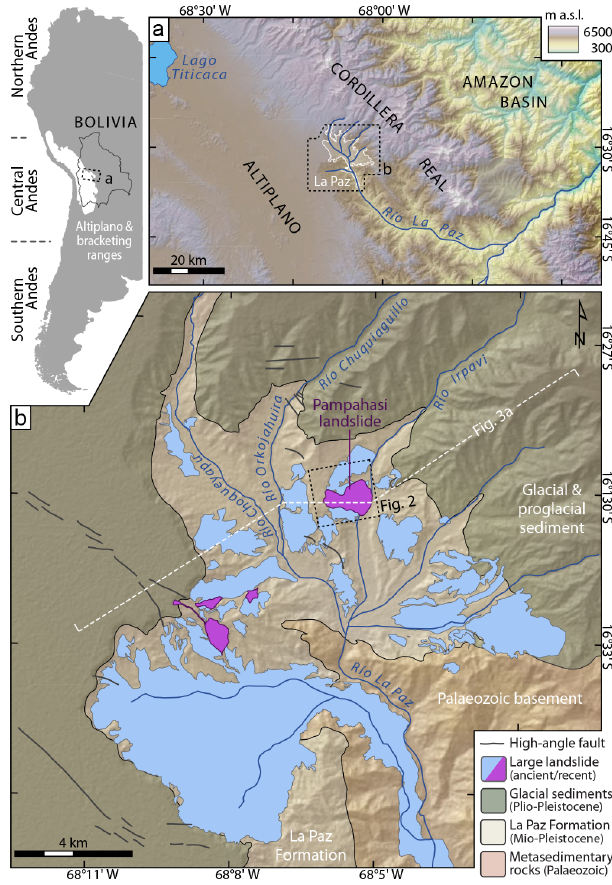
Figure 1. Setting of La Paz, Bolivia. (a) Location and physio- graphic context. (b) Generalized geology after Dobrovolny (1962) and Anzoleaga et al. (1977), with faults from Dobrovolny (1962) and Lavenu (1978). Terrain is from the ASTER GDEM v2 produced by METI and